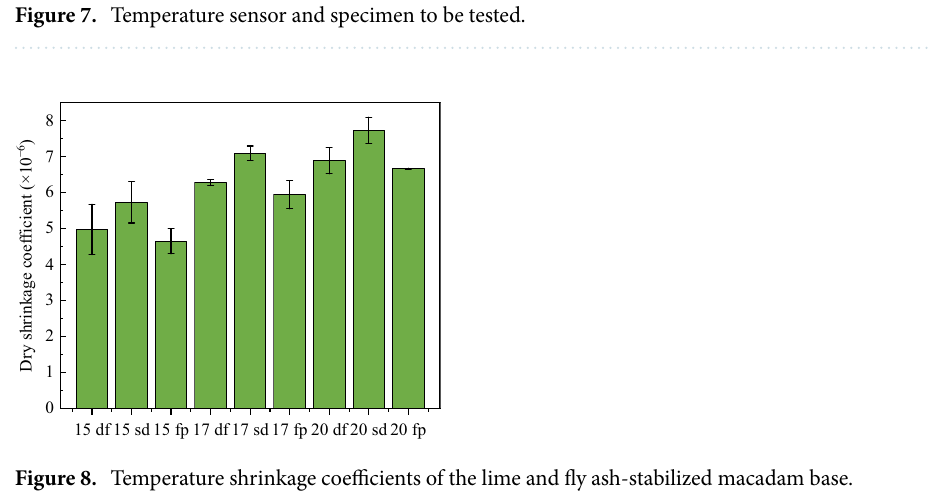
Figure 8. Temperature shrinkage coefficients of the lime and fly ash-stabilized macadam